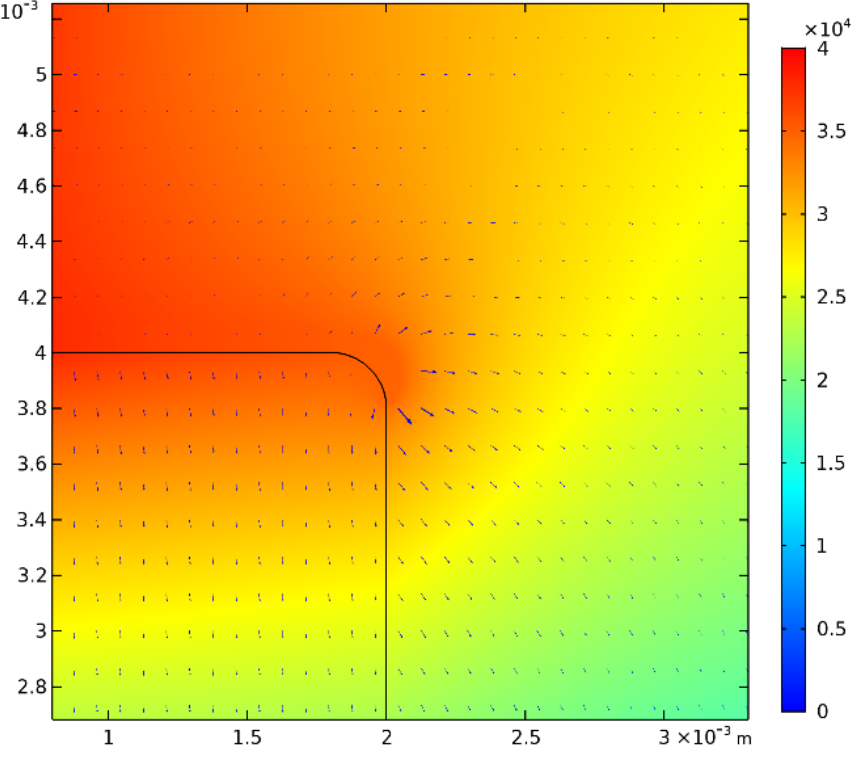
Figure 6. The potential (V) distribution at 0.57 ns (The longer the arrow, the larger the potential gradient).